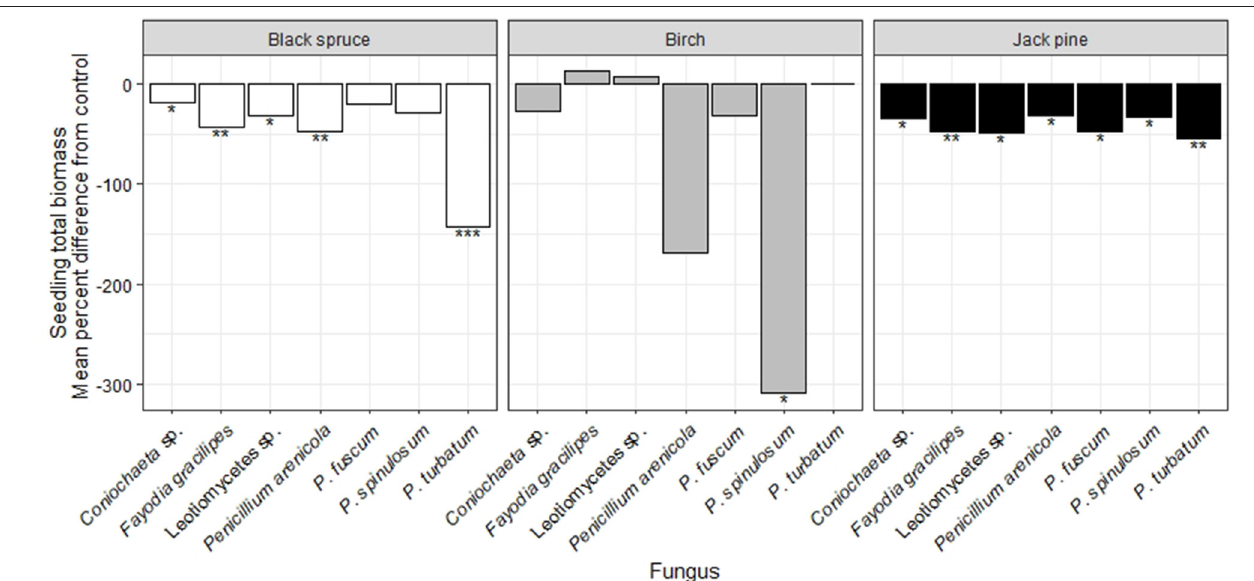
FIGURE 4 | Effects of seven heat-resistant fungi on seedling total biomass of black spruce (white bars), birch (gray bars), and jack pine (black bars) in growth chamber experiments over 10 wks. Results are presented as the mean percent difference for each fungal treatment from the uninoculated control treatment, based on 999 bootstraps. Values above zero indicate greater biomass when the fungus was inoculated, relative to the control. Asterisks indicate statistically significant differences relative to the control treatment from linear models (* P < 0.05; ** P < 0.01; *** P < 0.001; Table S6 ).